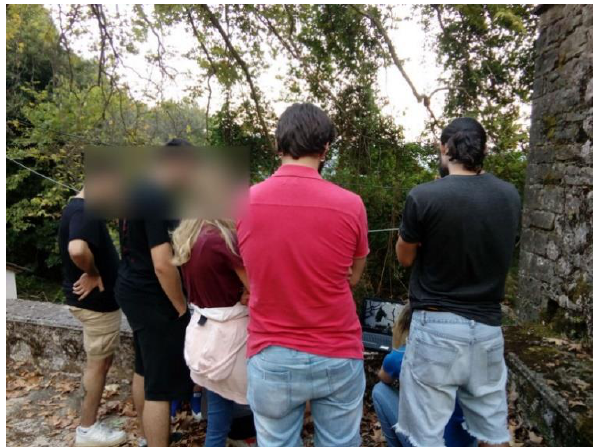
Figure 7. The debriefing-reflection phase with two teams ‘players.